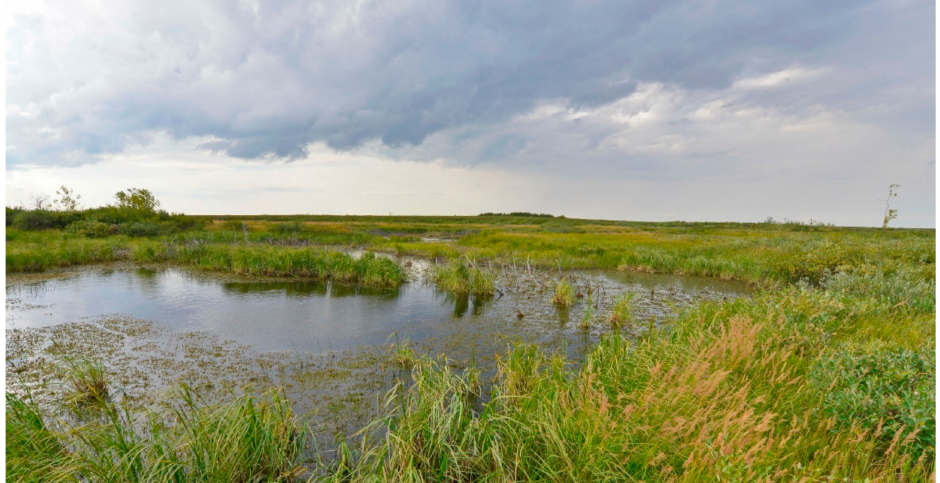
Figure A4. A thawed pond was formed instead of a frozen hillock with a willow-reedgrass community. Branches of dried willows out of the